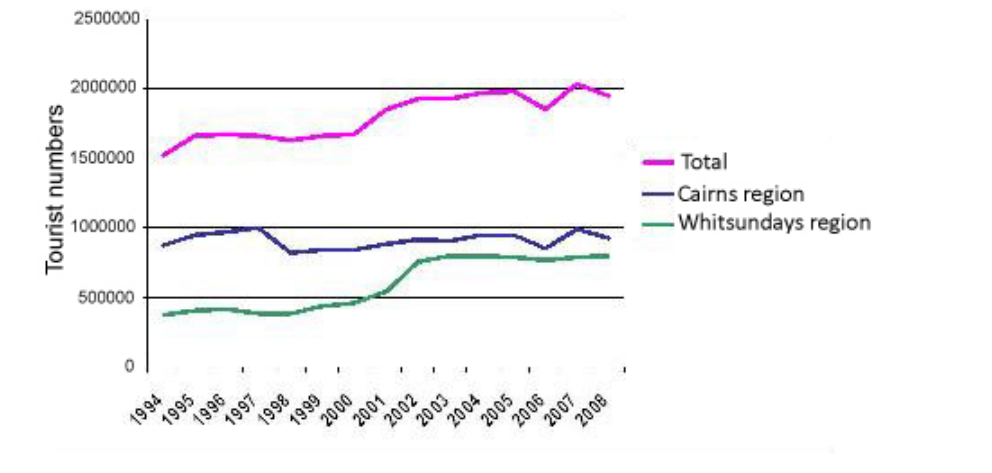
Fig. 1. Trends in visitors to the Great Barrier Reef and the Cairns and Whitsundays regions from 1994 to 2008. Source: GBRMPA 2009: Visitor data for Cairns to Cooktown Management Area and Whitsundays Planning Region http://www.gbrmpa.gov.au/corp_site/key_issues/tourism/management/